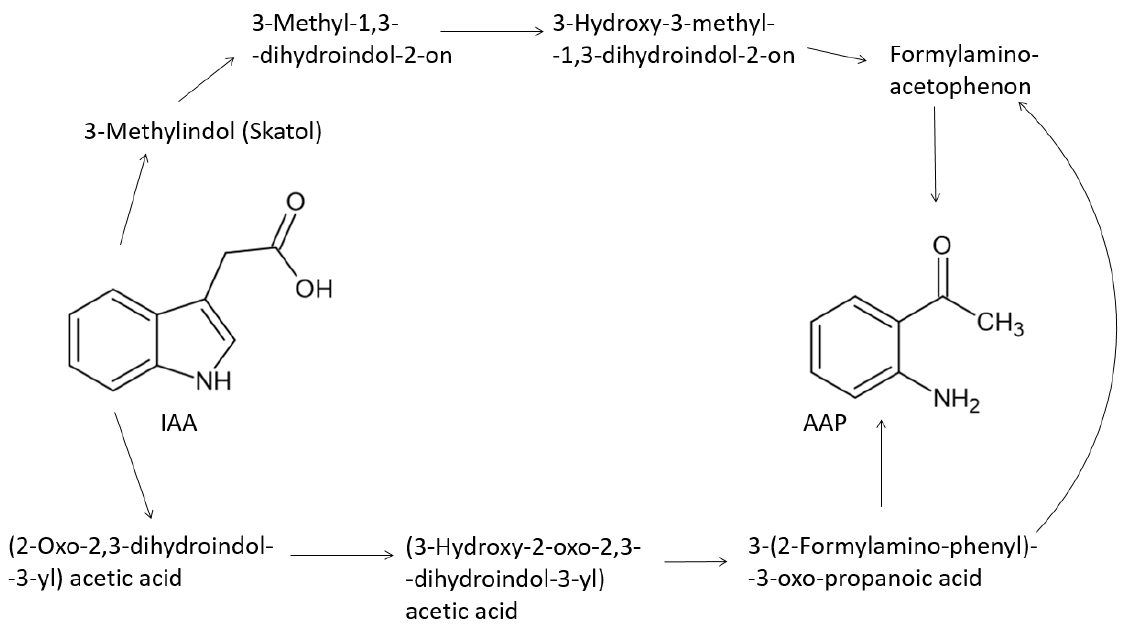
Figure 7. Degradation of indole-3-acetic acid to 2-aminoacetophenone, based on Christoph et al. [122] and Nardin et al. [106]. and Nardin et al.